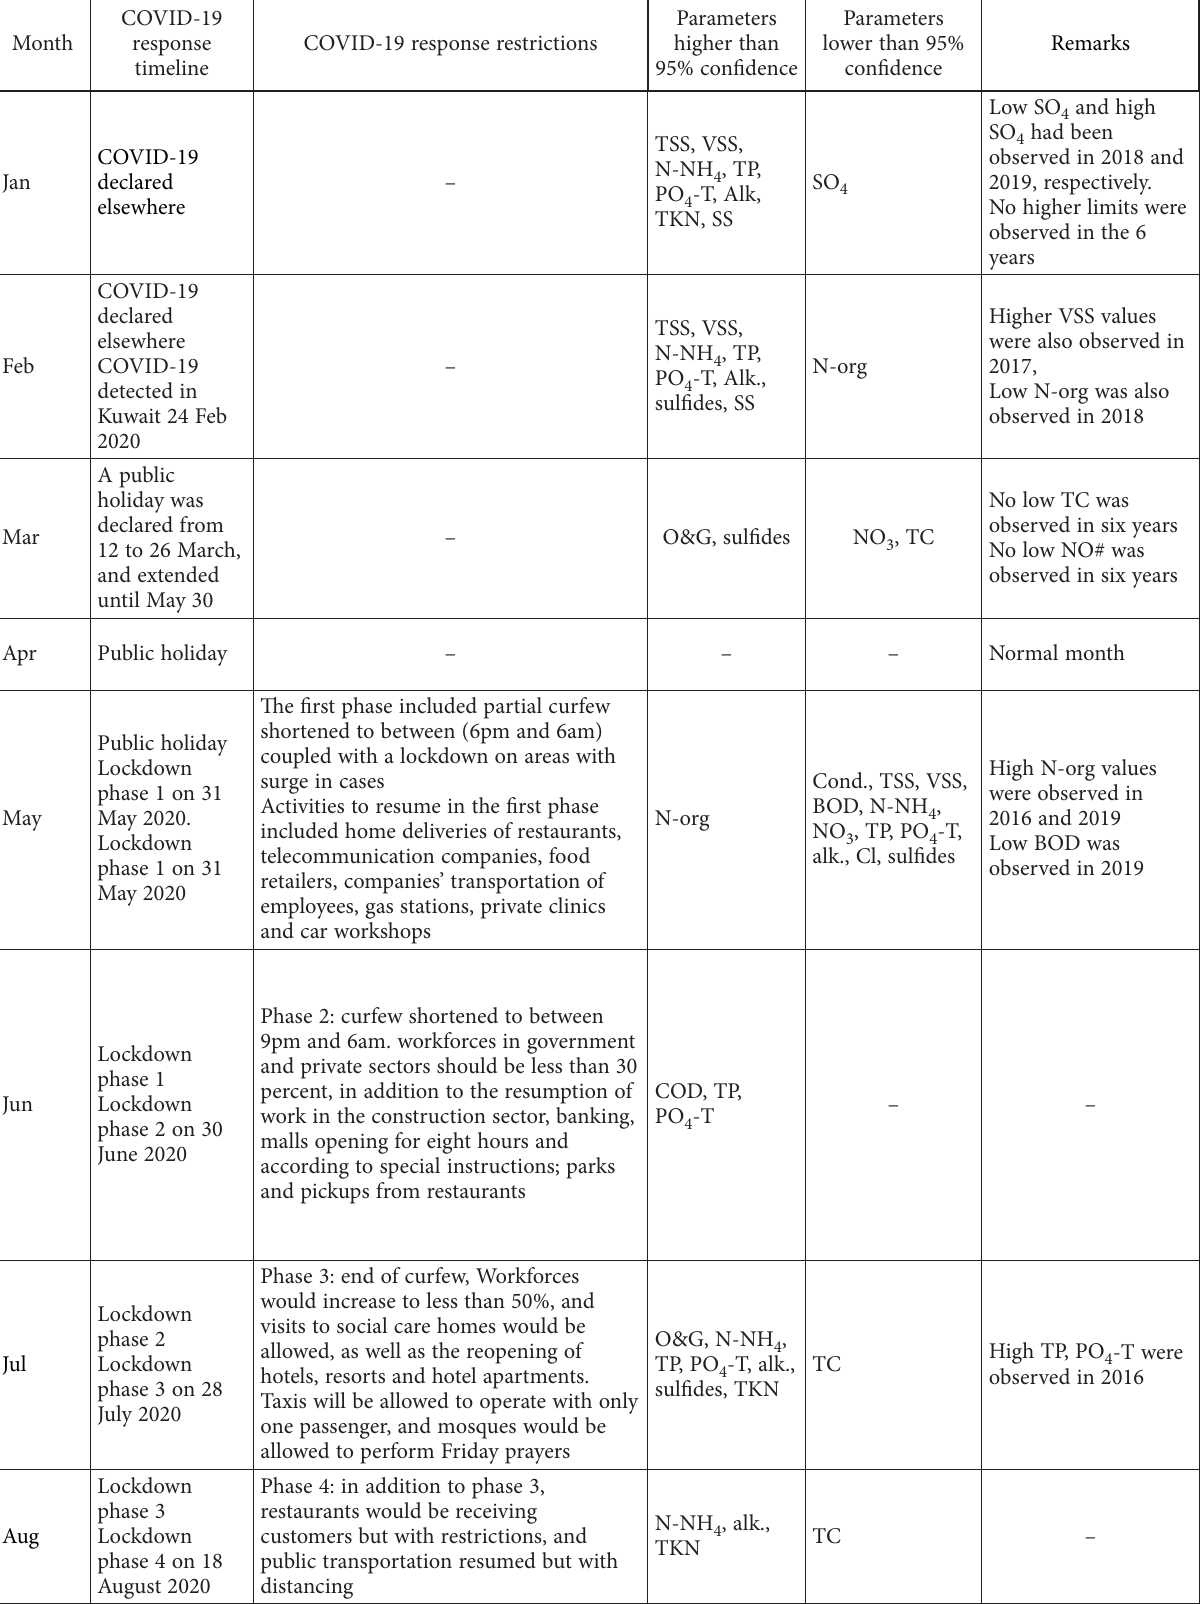
Table 5. Summary of 2020 extreme wastewater quality parameters versus COVID-19